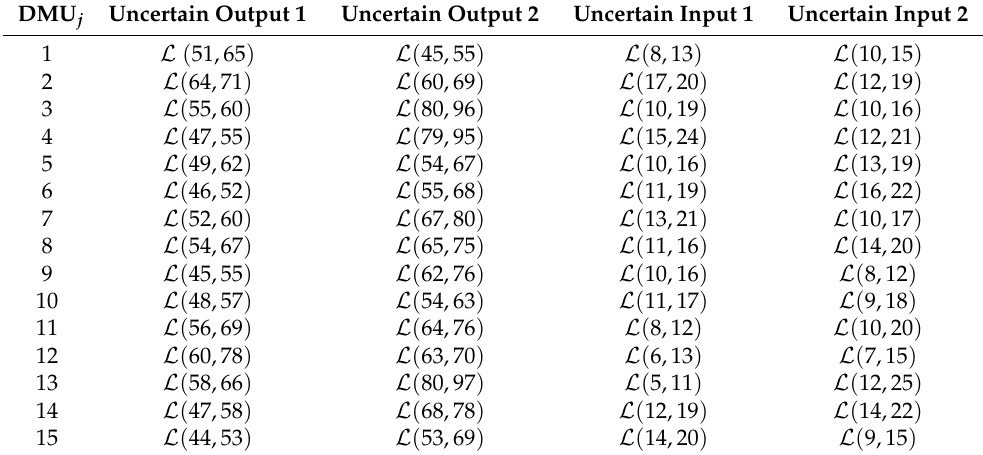
Table 2. 15 DMUs with two inputs and two